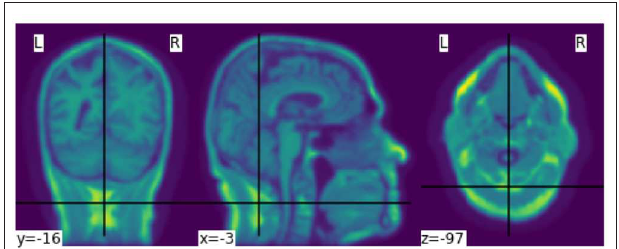
FIGURE 3 | Three slices of a 3D MR image; with sagittal, coronal, and axial plane.